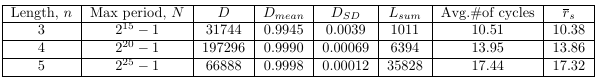
Table 6. The summary of simulation results over F Length, n Max period, N